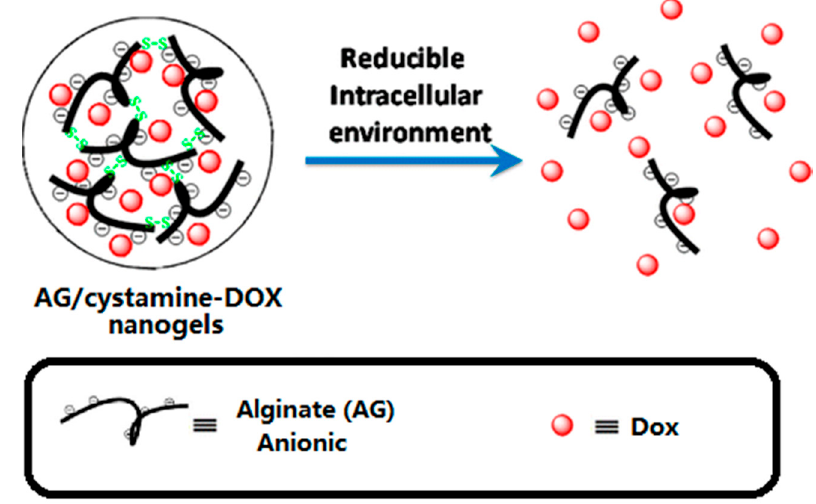
Figure 4. Schematic diagram of a polymer DDS. Reprinted with permission from [105]. Copyright 2013 American Chemical Society.